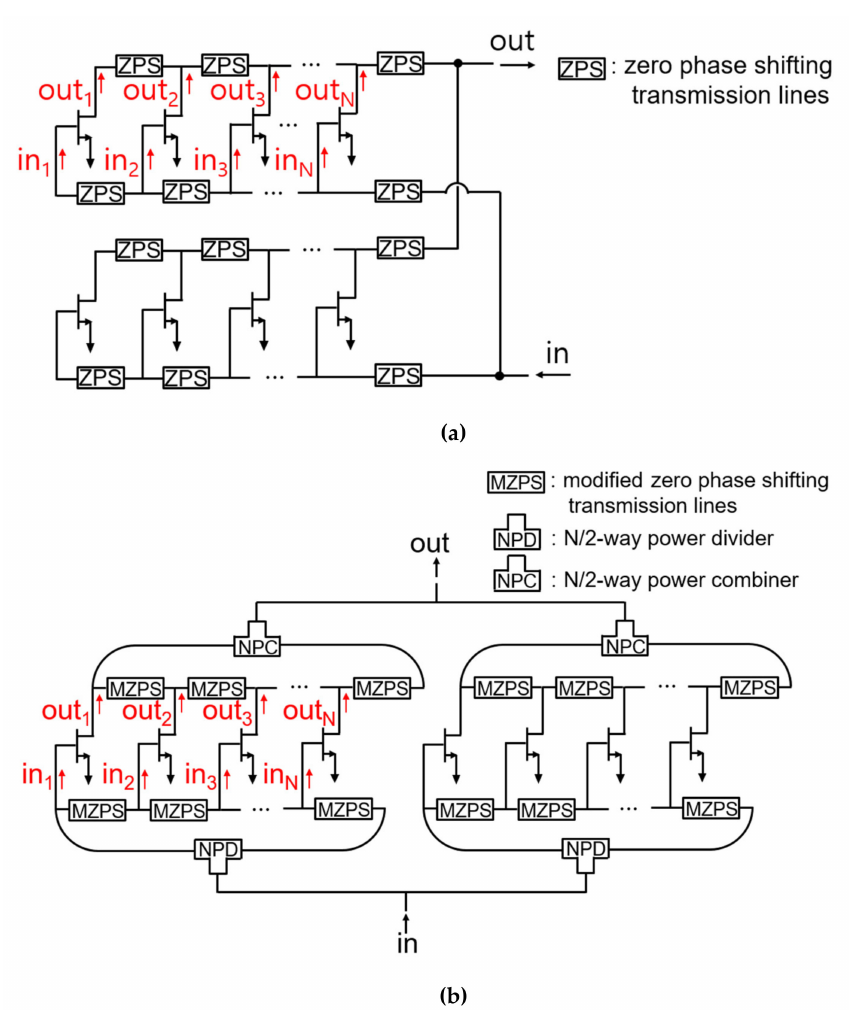
Figure 2. Block diagram of 2 × N distributed power-combining structure: ( a ) conventional single-ended dual-fed distributed power-combining and ( b ) proposed distributed power-combining